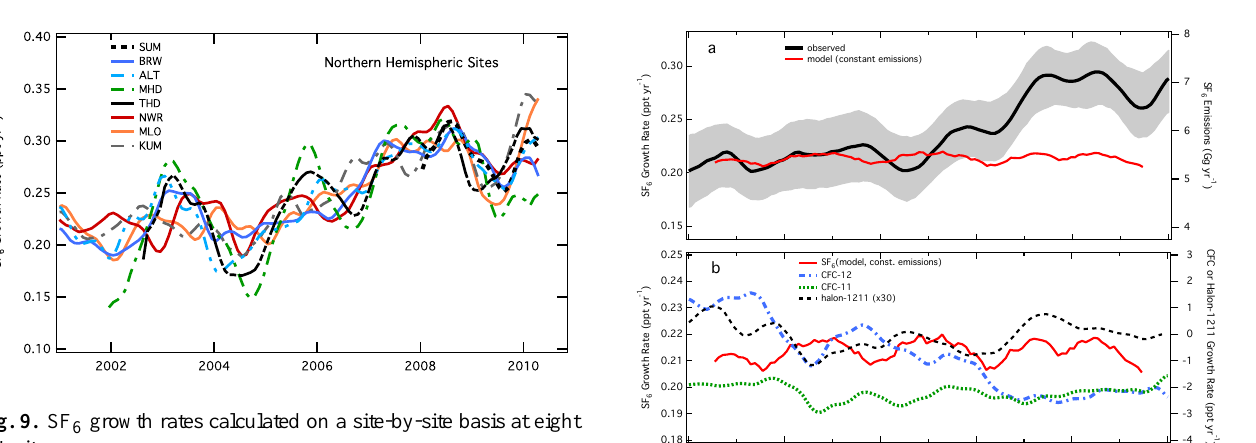
Figure 9: SF 6 growth rates calculated on a site-by-site basis at eight N.H. sites. 564 Fig. 9. SF 6 growth rates calculated on a site-by-site basis at eight NH sites.